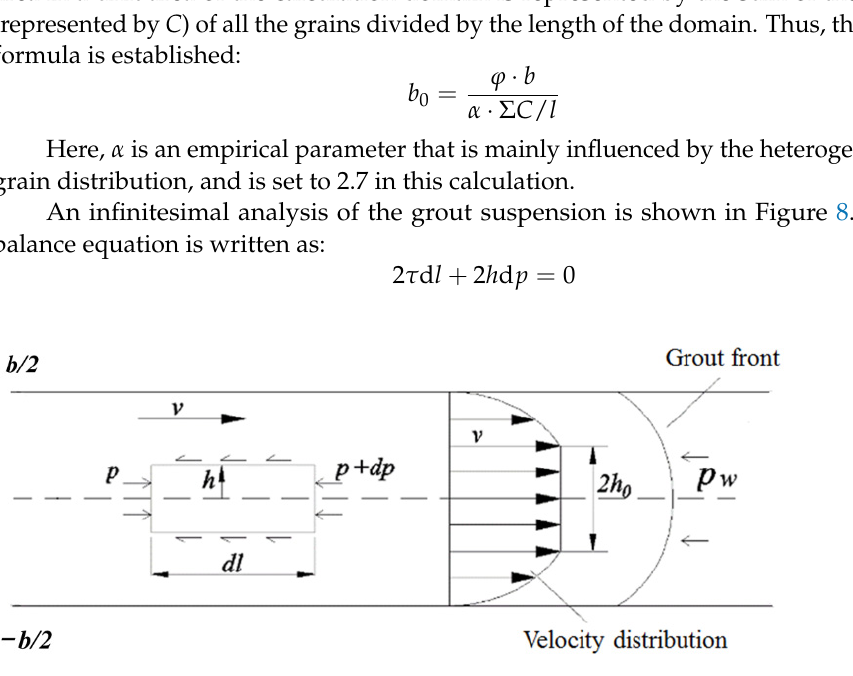
Figure 8. Infinitesimal analysis of the grout suspension.